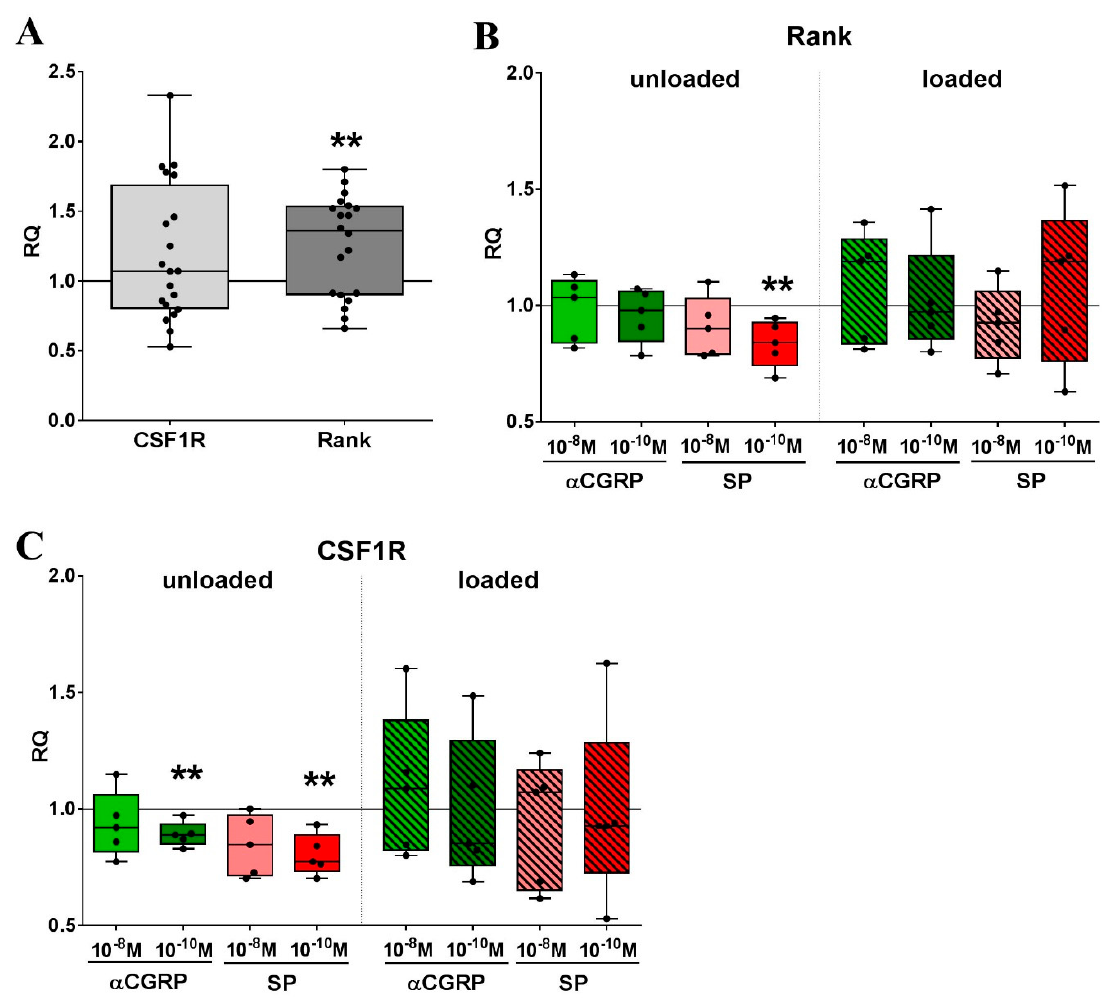
Figure 6. The impact of mechanical loading and sensory neuropeptide stimulation on the gene expression of osteoclast differentiation markers in RAW264.7 cells. ( A ) Analysis of gene expression of the receptor for M-CSF ( CSF1R ) and Rank in loaded RAW264.7 cells in relation to non-loaded cells (= calibrator, RQ = 1) analyzed by quantitative real-time PCR; ( B , C ) Gene expression of Rank ( B ) and CSF1R ( C ) in loaded and unloaded RAW264.7 cells stimulated with SP and α CGRP compared to the respective unstimulated cells (calibrator, RQ = 1). Normalizer: GAPDH. One sample t -test * p < 0.05; ** p < 0.01; *** p < 0.001. unstimulated n = 20, stimulated n = 5. CSF1R — colony stimulating factor 1